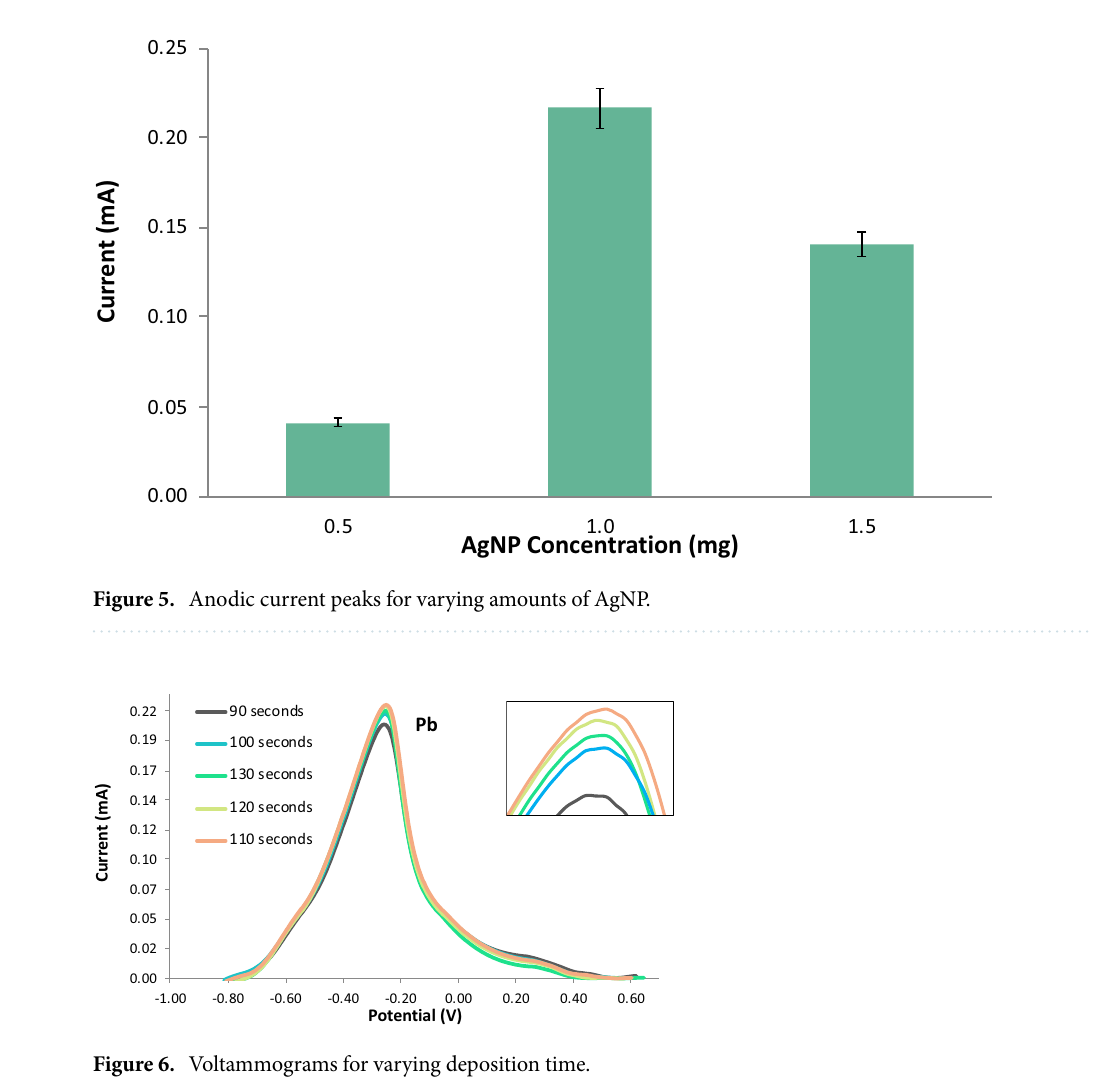
Figure 4. Voltammograms for varying amounts of electrode modifier.